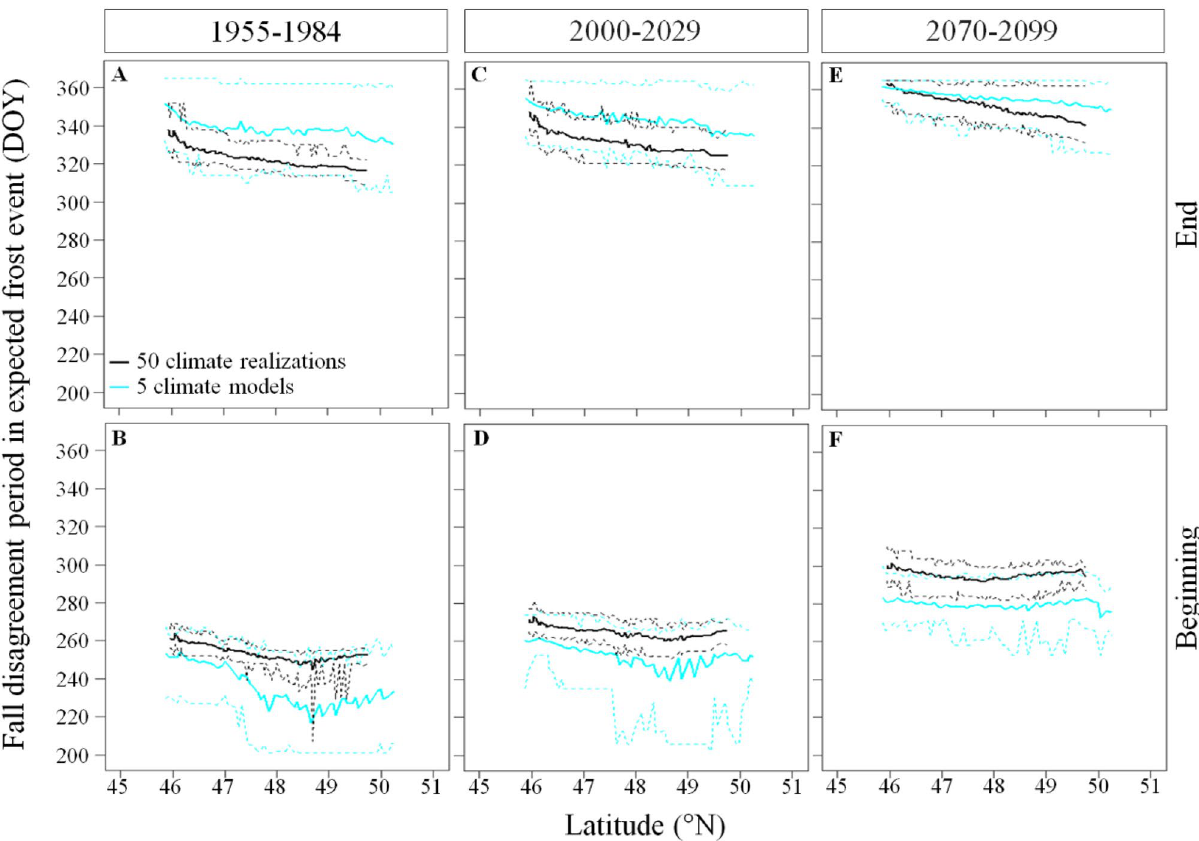
Figure 6. Inter and intra climate model variability in the day of year of the beginning and end of the disagreement period in expected frost occurrence during fall across latitudes and 30-year periods. The solid lines represent the means, and the dashed lines the maximum and minimum DOY determining the beginning and end of the disagreement period in expected frost occurrence across latitudes. The disagreement period